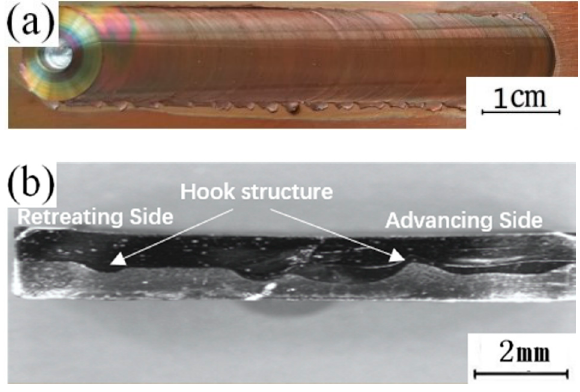
Figure 2. ( a ) Weld surface; ( b ) Weld interior.